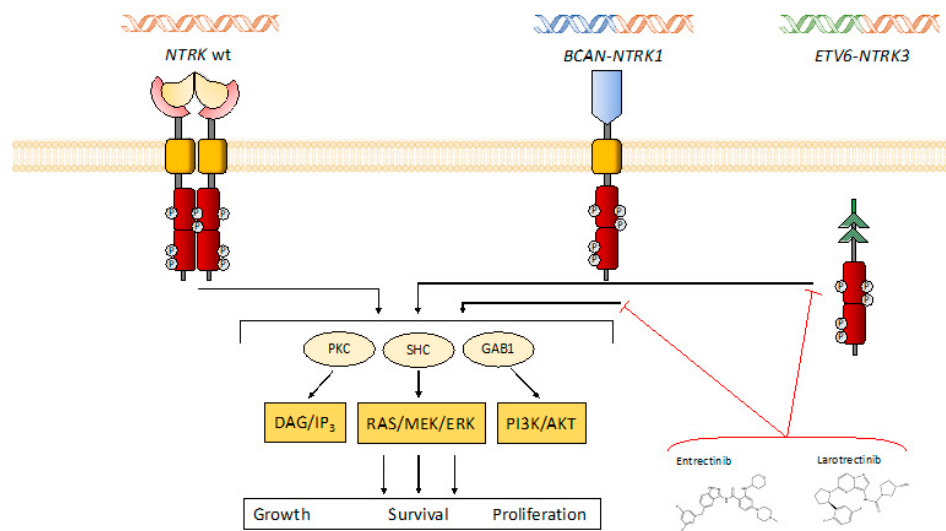
Figure 1. Physiological and rearranged NTRK genes / TRK receptors and intracellular signaling. The PLC- γ , MAPK, and PI3-K intracellular pathways (here represented by the DAG / IP3, RAS / MEK / ERK, and PI3-K / AKT components, respectively) are activated either from the wild-type form of NTRK , and the chimeric fusion receptors (e.g., BCAN - NTRK1 and ETV6 - NTRK3 ). However, the latter happens in a ligand-free constitutively activated fashion, leading to oncogenic activation. The NTRK inhibitors (TKI, here represented by entrectinib and larotrectinib) achieve their antitumor activity by interacting with the intracellular domain of the chimeric receptors, inhibiting the recruitment of the signaling pathway.